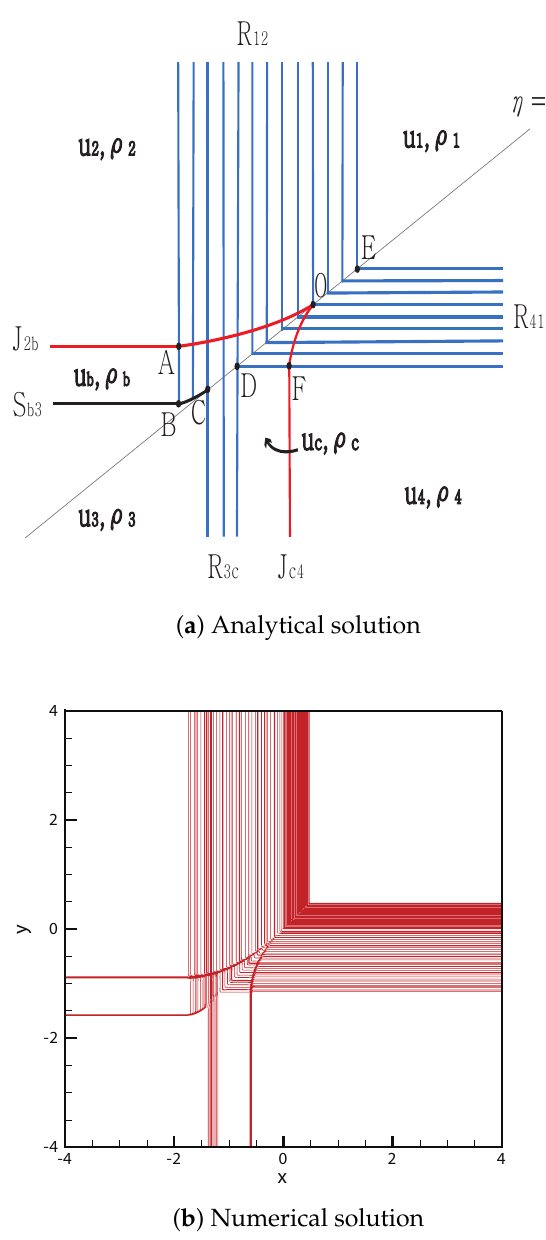
Figure 9. Case 7. R + JS + RJ +